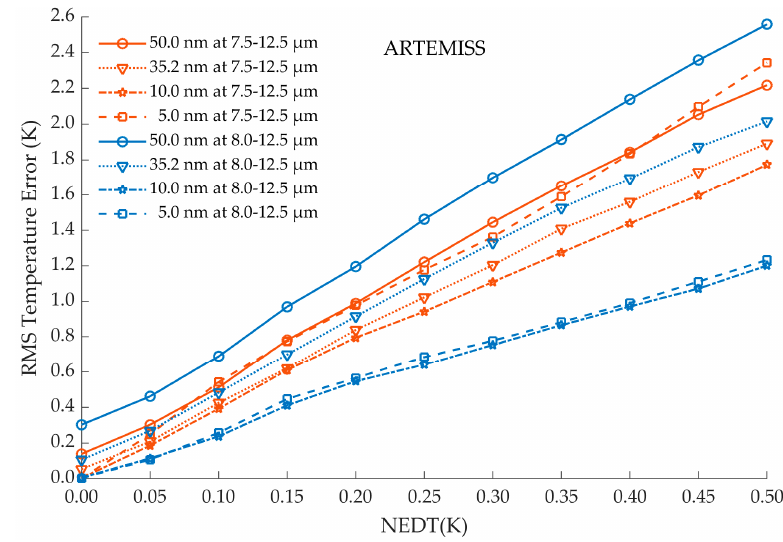
Figure 1. Plot of automatic retrieval of temperature and emissivity using spectral smoothness (ARTEMISS) land surface temperature (LST) inversion errors varying with noise equivalent temperature difference (NEDT), spectral range and spectral resolution.